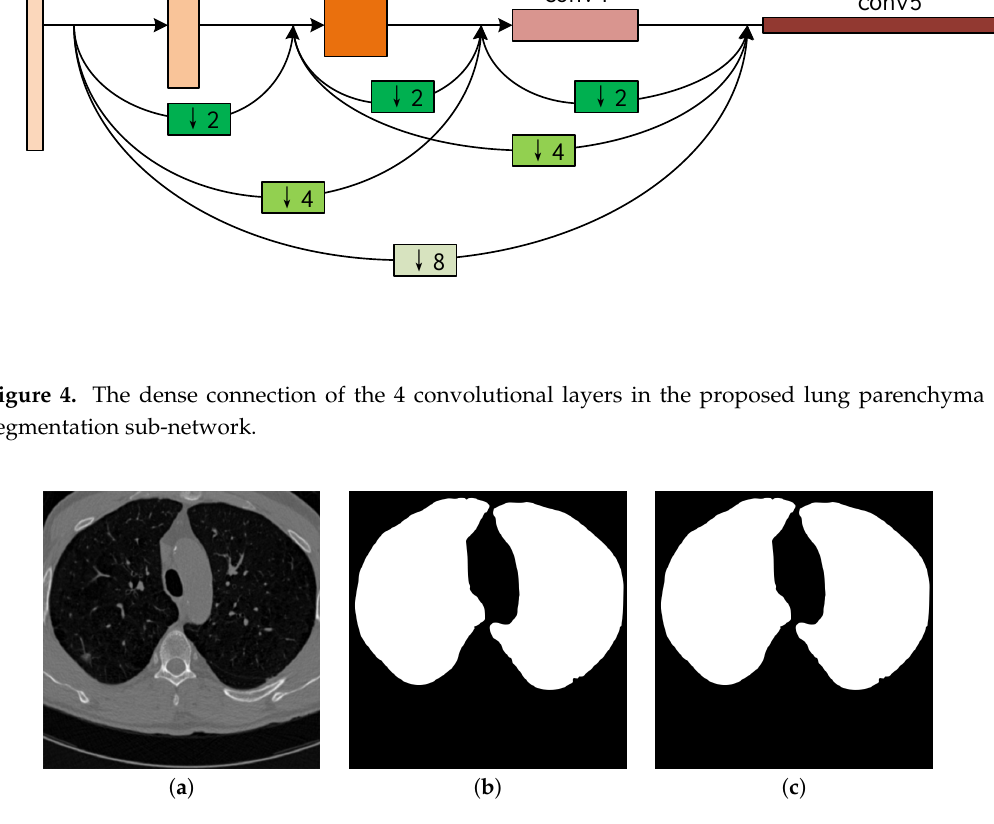
Figure 5. An example of segmenting parenchyma mask from the chest CT image. ( a ) is the input chest CT image, ( b ) is the lung parenchyma mask detected by the proposed parenchyma detection sub-network, ( c ) is the ground truth lung parenchyma